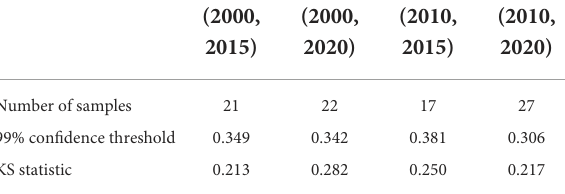
TABLE 4 KS test of Large impact type: the critical value of the KS statistic at 99 % confidence and the KS statistic for each fixed time horizon.